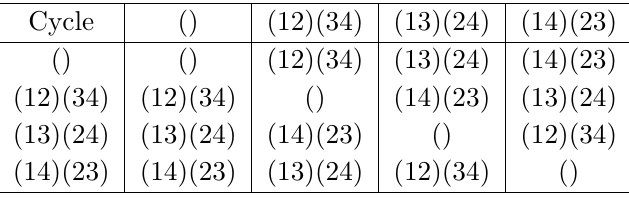
Table 4 . Multiplication of fV